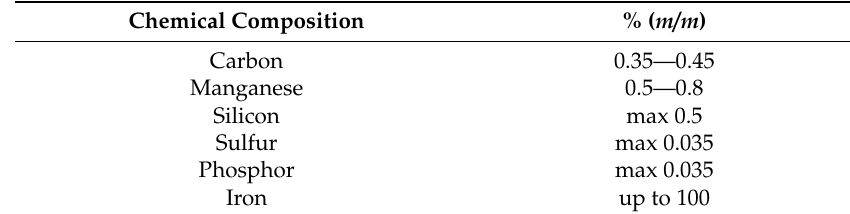
Table 5. Chemical composition of the steel plates used in the